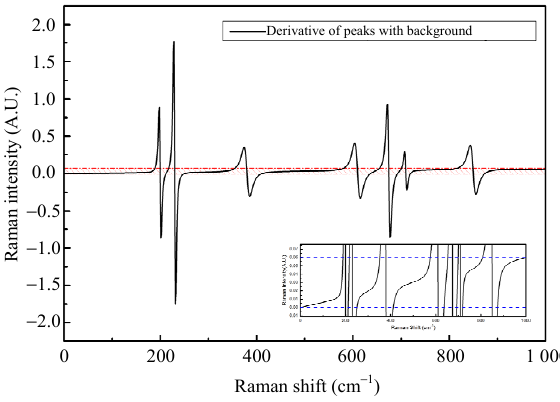
Fig. 5 Derivative of the synthetic Raman spectrum.